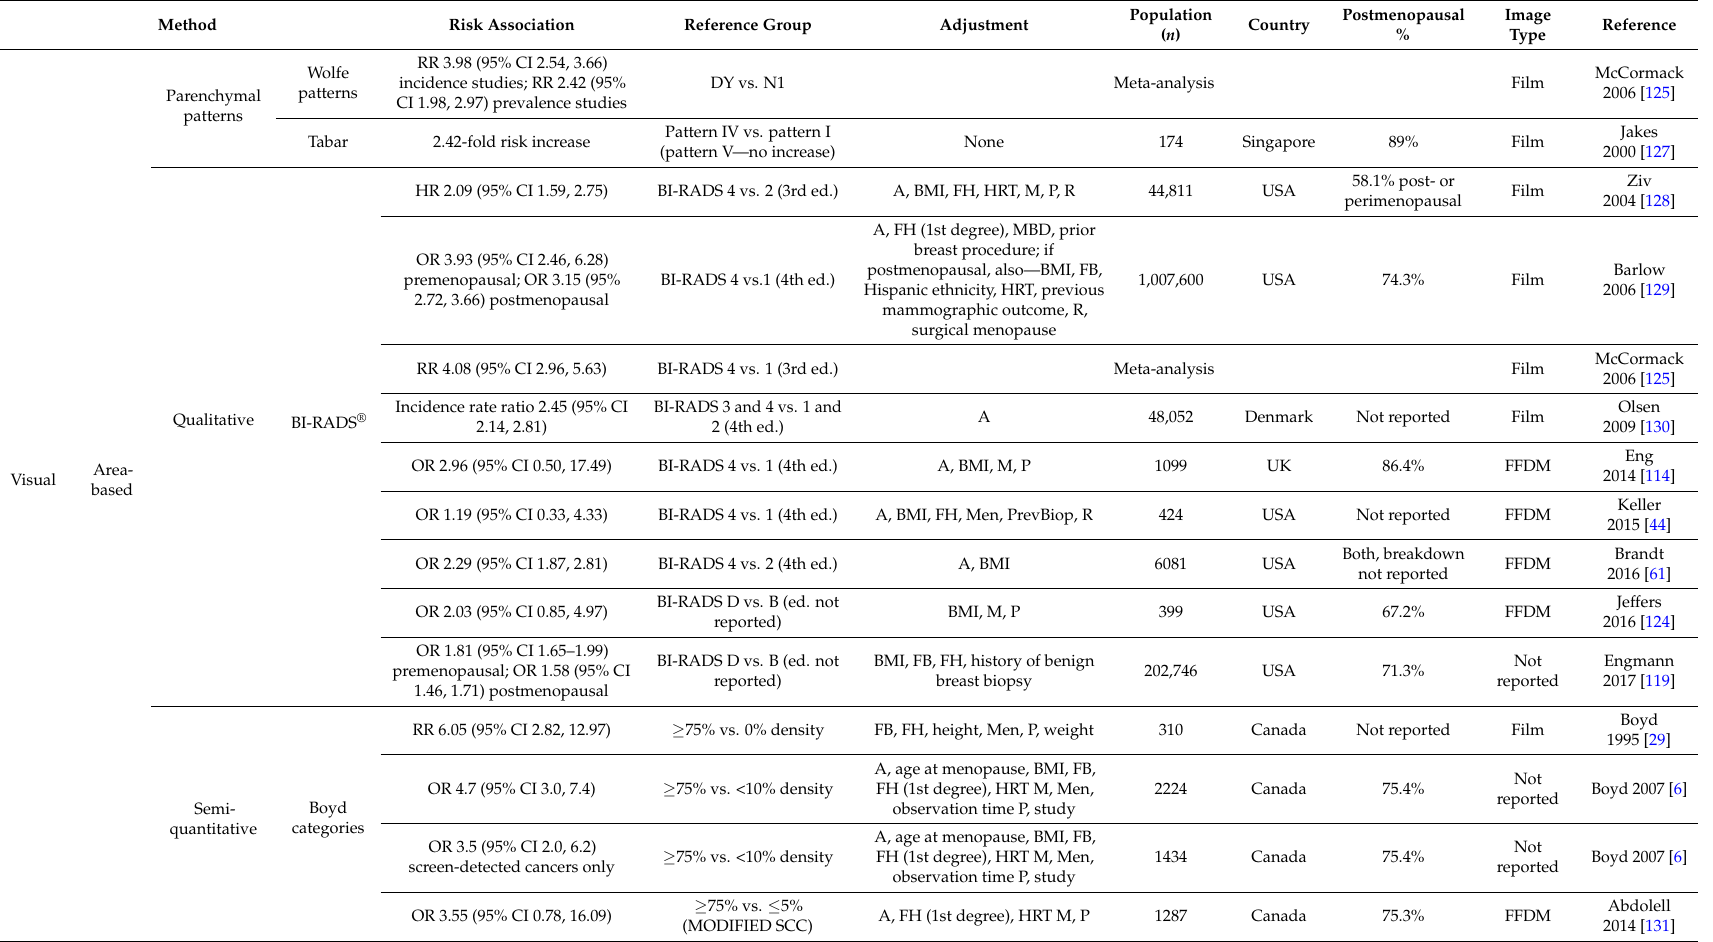
Table 3. Association of breast cancer risk with visual methods of measuring